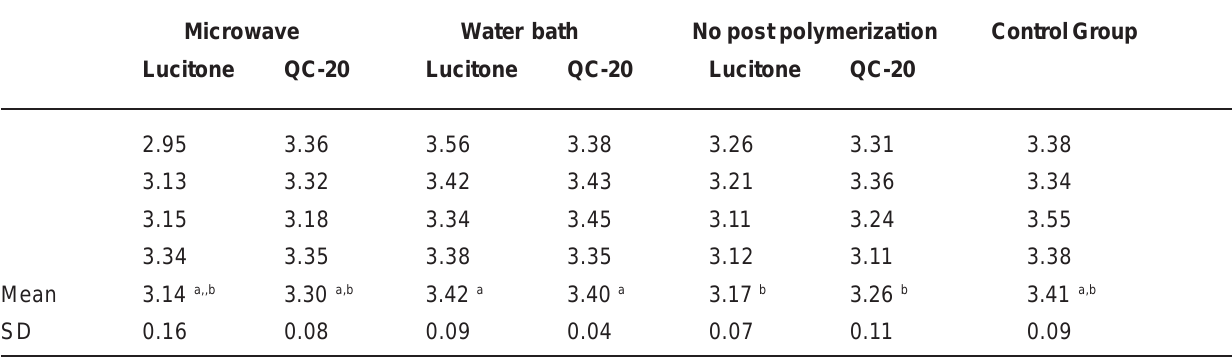
Means designated with the same superscript were not statistically different